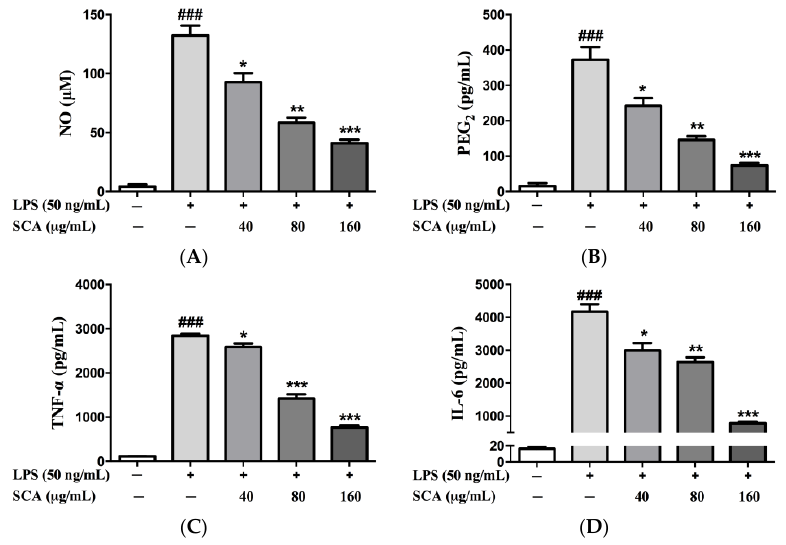
Figure 3. Effects of SCA on the productions of NO ( A ); PGE 2 ( B ); TNF-α ( C ) and IL-6 ( D ). RAW 264.7 macrophages were treated with SCA at the concentrations of 40, 80 and 160 μg/mL, respectively, for 1 h, and then stimulated with 50 ng/mL LPS for 24 h. The concentrations in the cell-free culture were measured by enzyme-linked immunosorbent assay (ELISA). * p < 0.05, ** p < 0.01 and *** p < 0.001 versus LPS-only treatment group; ### p < 0.001 versus control group.